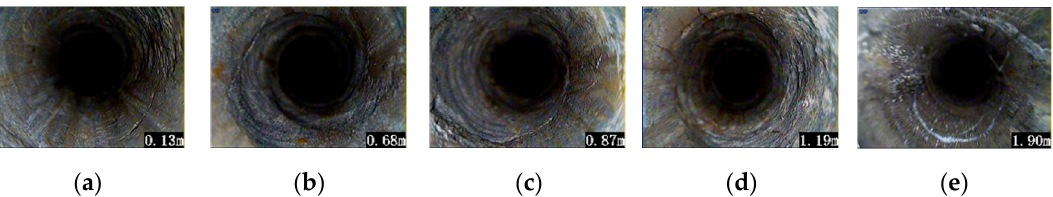
Figure 14. Borehole observation under the new support. ( a ) 0.13 m; ( b ) 0.68 m; ( c ) 0.87 m; ( d ) 1.19 m; ( e ) 1.90 m. (2) Axial force monitoring of bolts and cables.